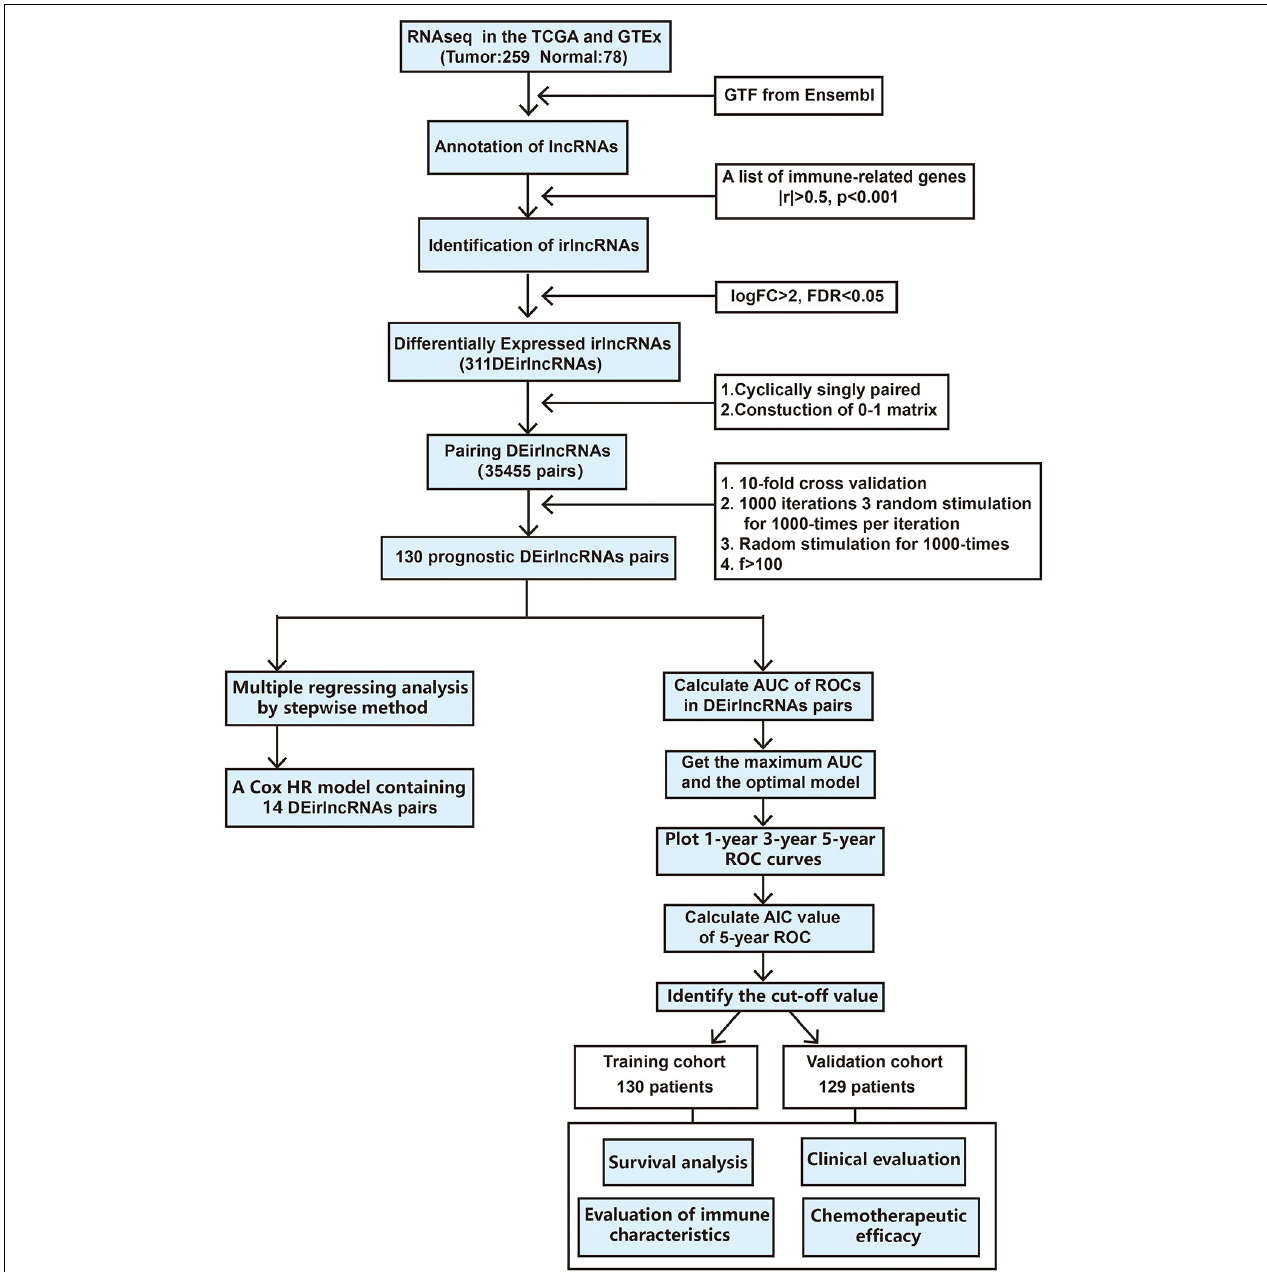
FIGURE 1 | Flowchart of this